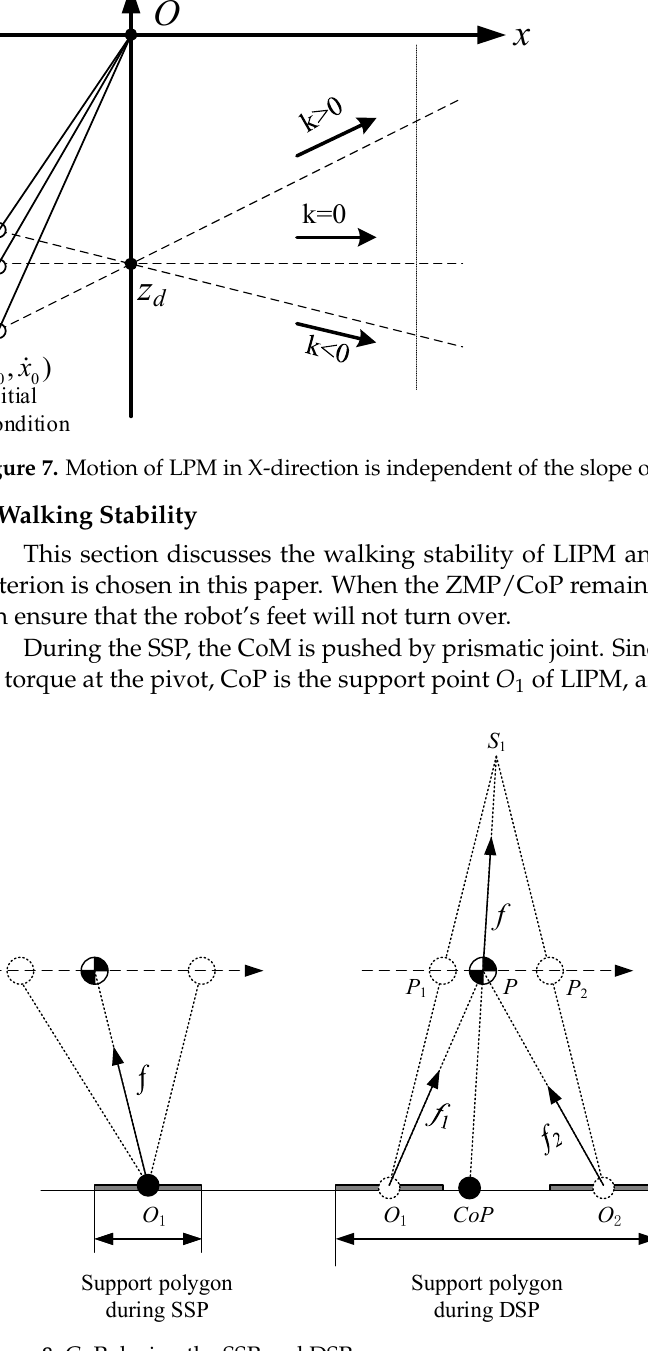
Figure 8. CoP during the SSP and DSP.